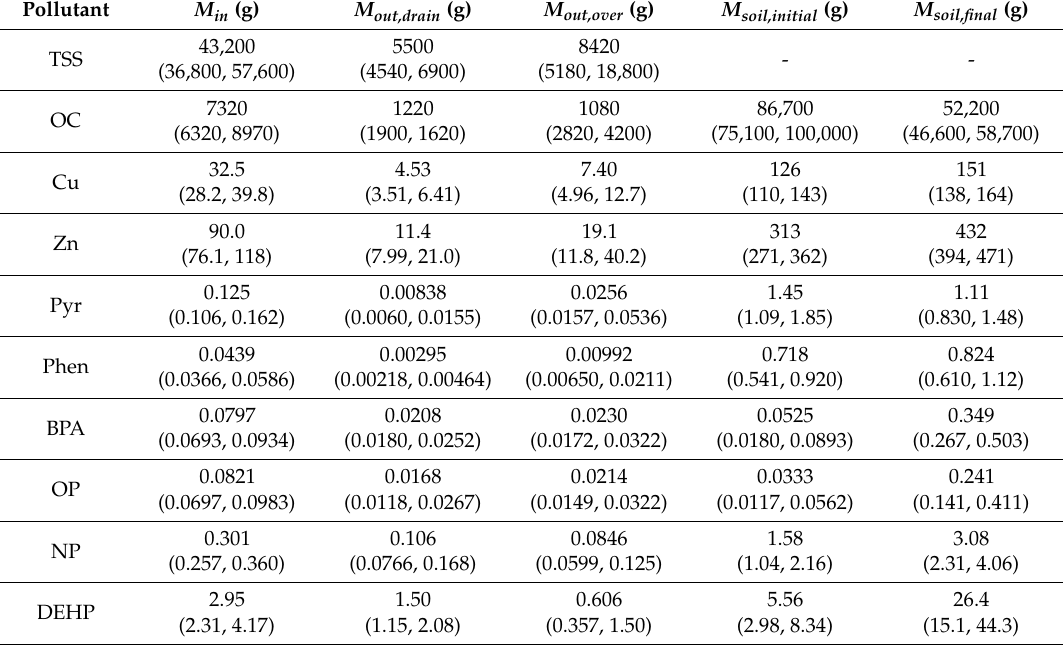
Table A6. Summary of all mass balance terms. Individual mass balance terms associated with water fluxes (inlet mass from road runoff– M in , outlet mass from drain– M out,drain , outlet mass from